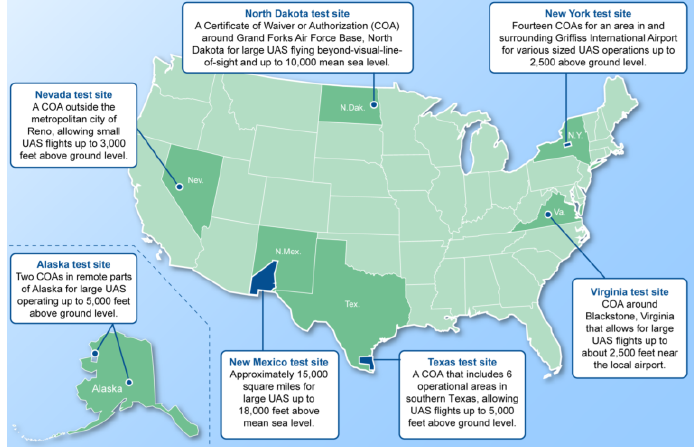
Figure 6. FAA UAS test sites participating in the UTM program and sample of the existing test sites’ certificate of authorization locations and allowable unmanned aircraft system operations, as of October 2019 [20] (p. 11).